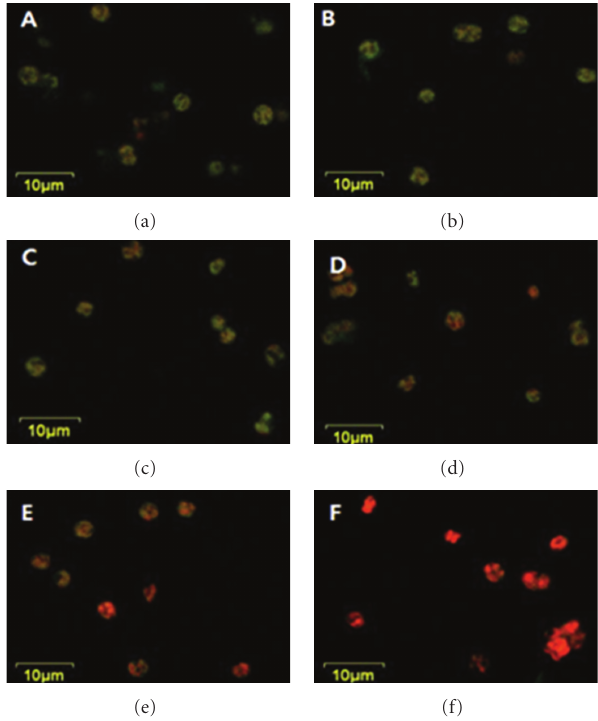
Figure 3: Comparison of the confocal laser microscopic images of Scenedesmus sp. illustrates the Nile red stained residual cellular lipid droplets after being extracted by five di ff erent extraction solvents including the control; (a) control (not extracted with any solvent), (b) acetone, (c) 95% hexane, (d) hexane:ether (1:1, v/v), (e) 70% ethanol, and (f) chloroform:methanol (2:1, v/v). hexane : ether (1 : 1, v/v), and 70% ethanol, respectively. It implies that the most proper extraction solvent for this alga would be chloroform : methanol (2 : 1, v/v), which could also be supported by the results that show mixing two or three solvents would be better for lipid extraction [5,